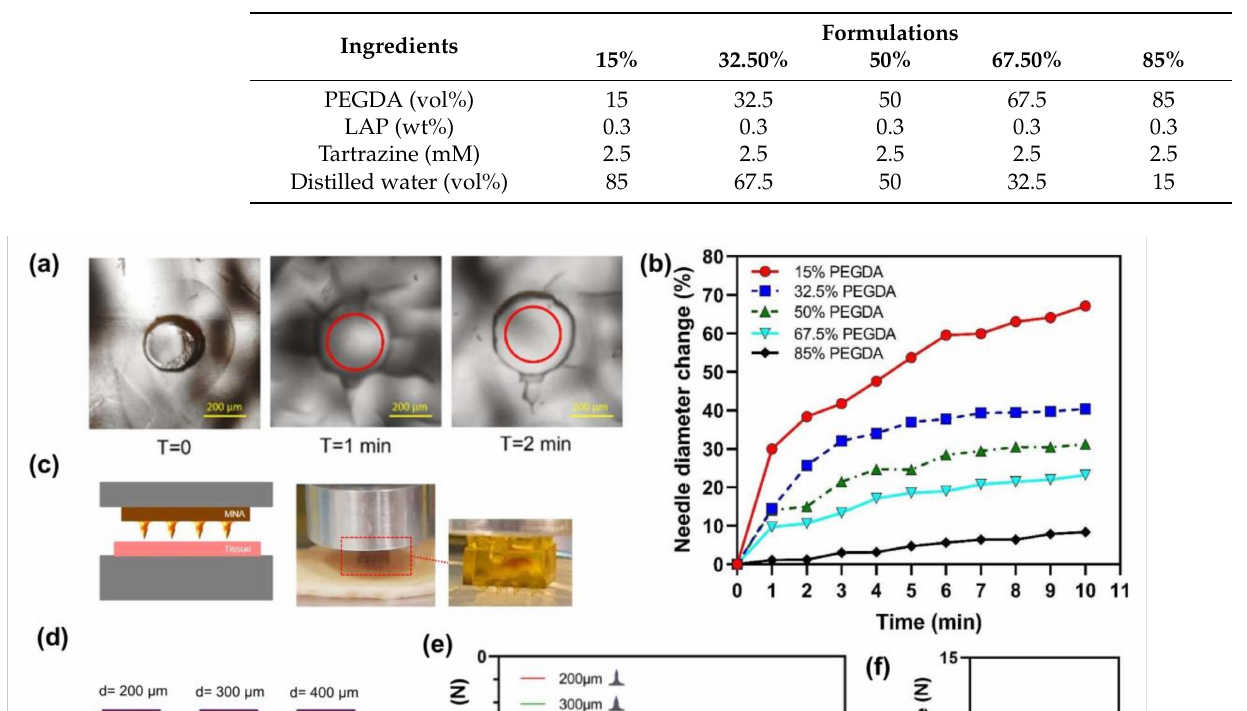
Table 1. Different formulations to study the swelling properties of MNAs.